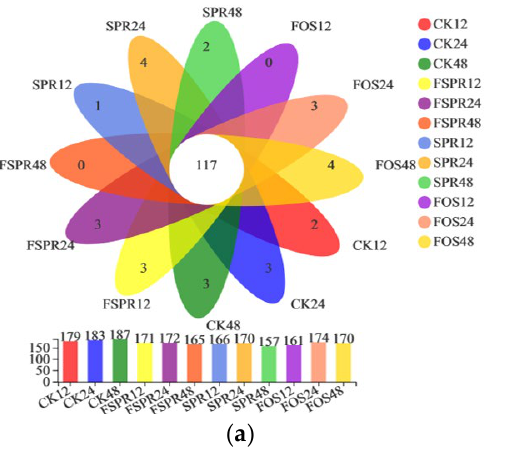
Figure 5. Venn diagram ( a ) and percent of community abundance ( b ) of gut microbiota at genus level during in vitro colonic fermentation; CK12, CK24, and CK48: Colonic fermentation